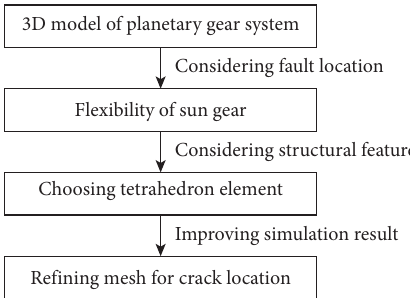
Figure 5: Flexibilization steps of sun gear.